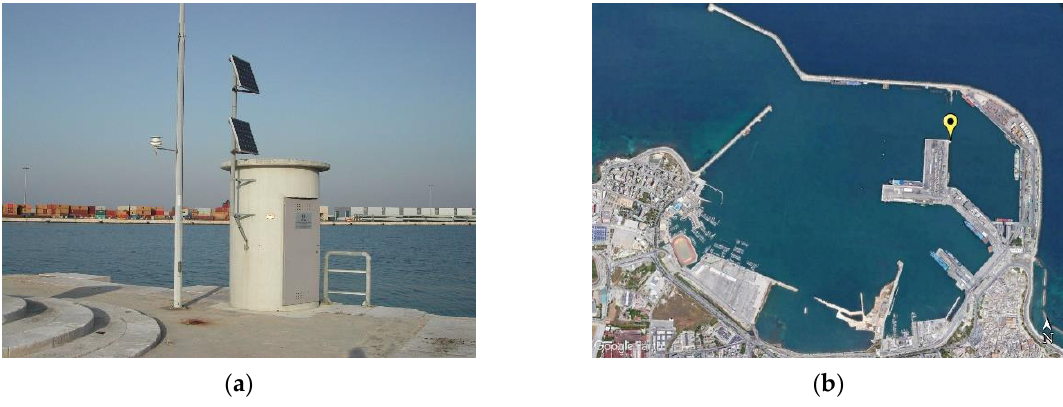
Figure 7. The ISPRA’s monitoring station in the port of Bari: ( a ) the station (picture from https://www.mareografico.it/ (accessed on 25 October 2021)); ( b ) its position (16 ◦ 51 (cid:48) 57.72” E, 41 ◦ 08 (cid:48) 24.74” N, image from Google